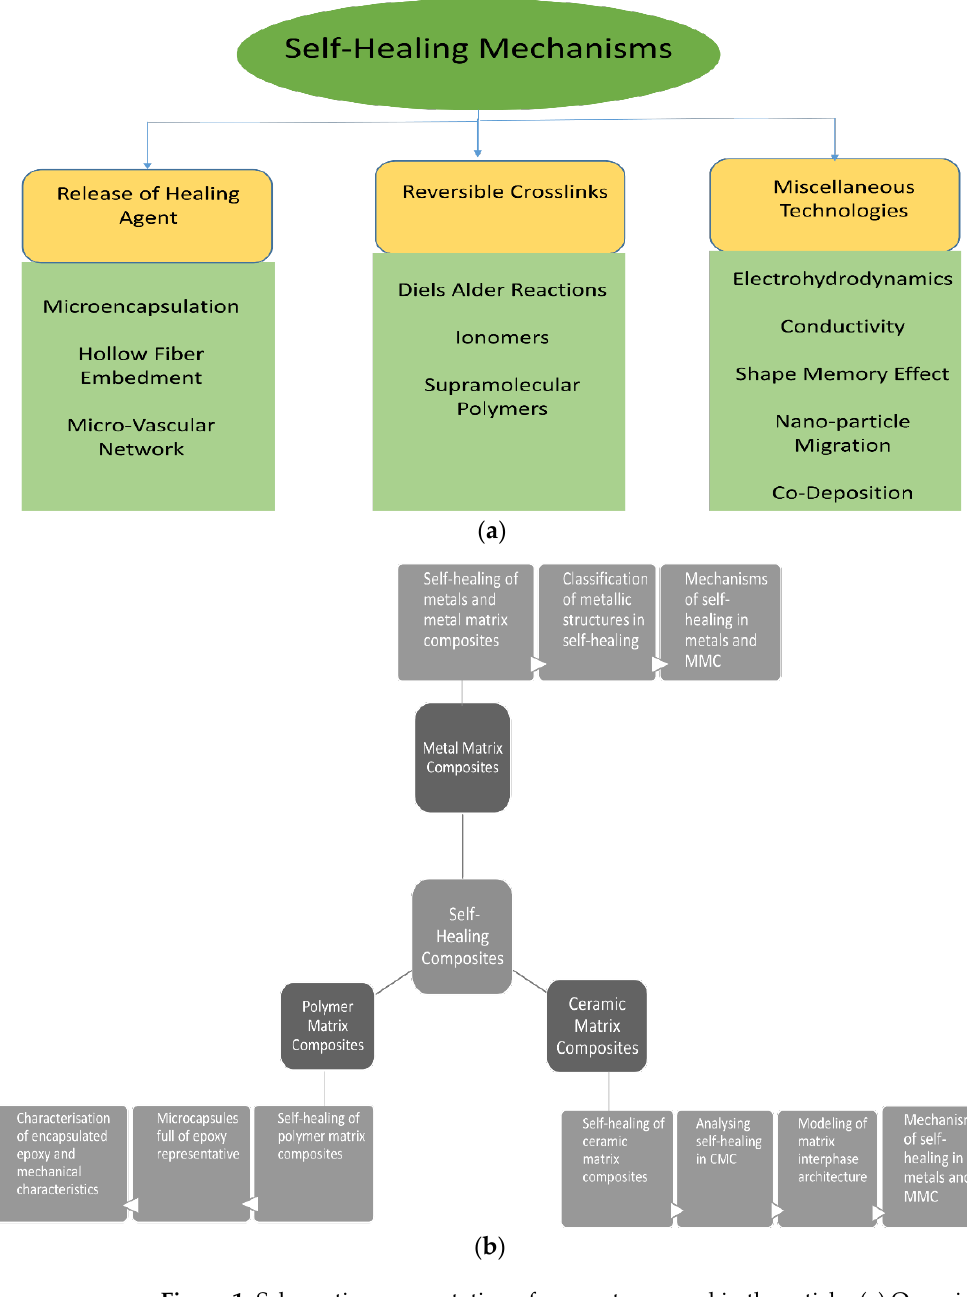
Figure 1. Schematic representation of concepts covered in the article. ( a ) Overview of Self-healing mechanisms and chemistry. ( b ) Applying self-healing techniques in various composites such as metals, polymers, and ceramics.